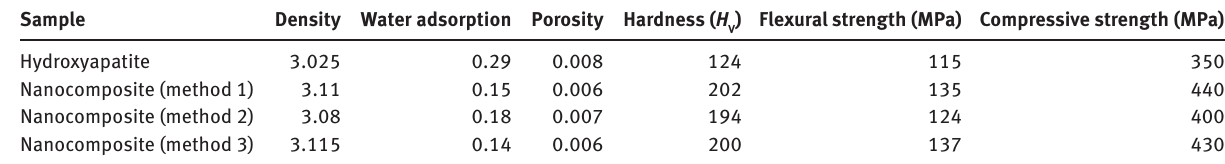
Table 1: The physical and mechanical properties of as-synthesized hydroxyapatite and nanocomposites. Sample